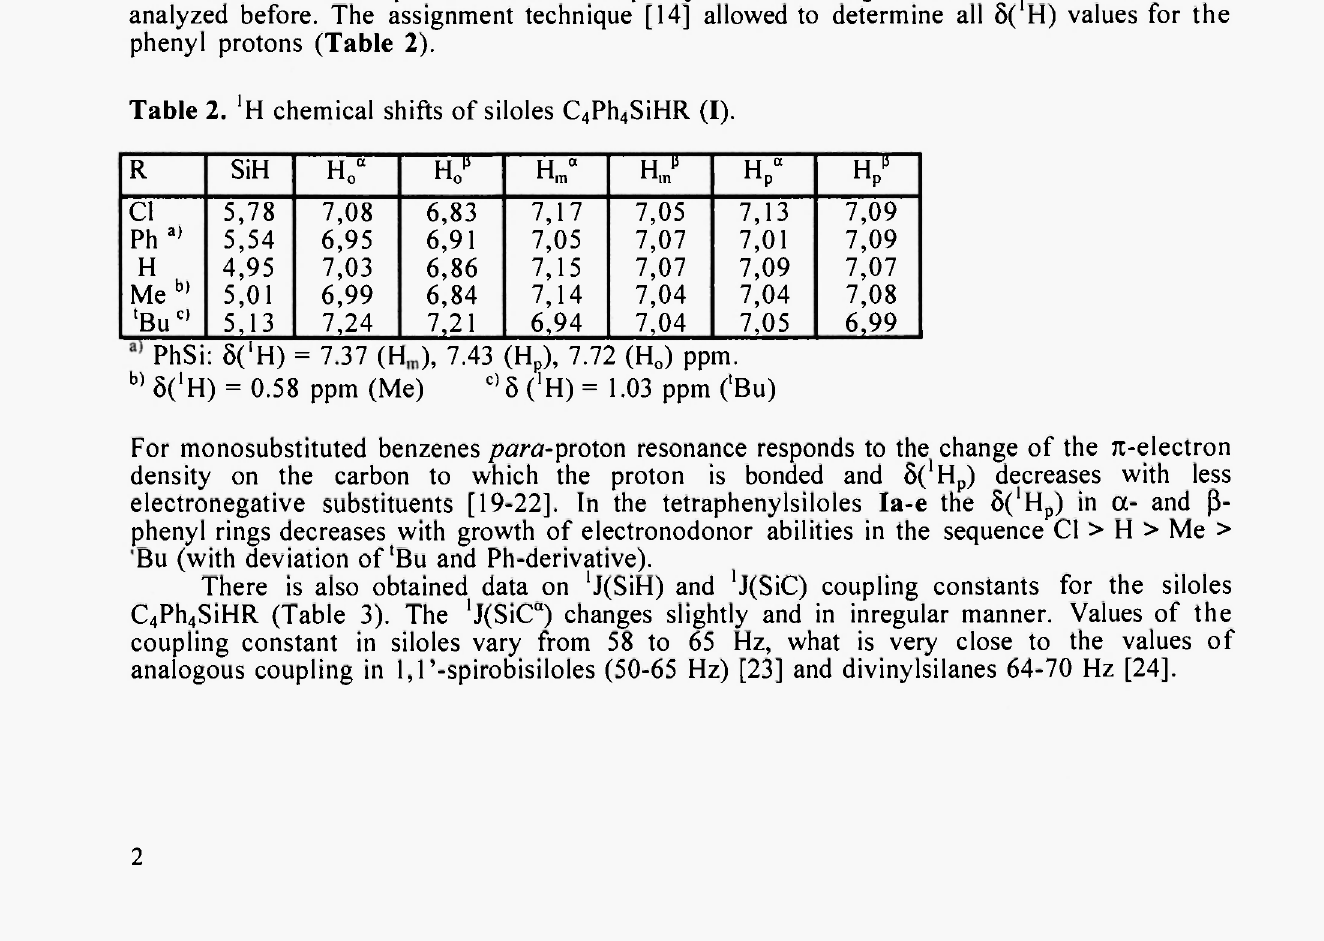
Table 2. 'H chemical shifts of siloles C 4 Ph 4 SiHR